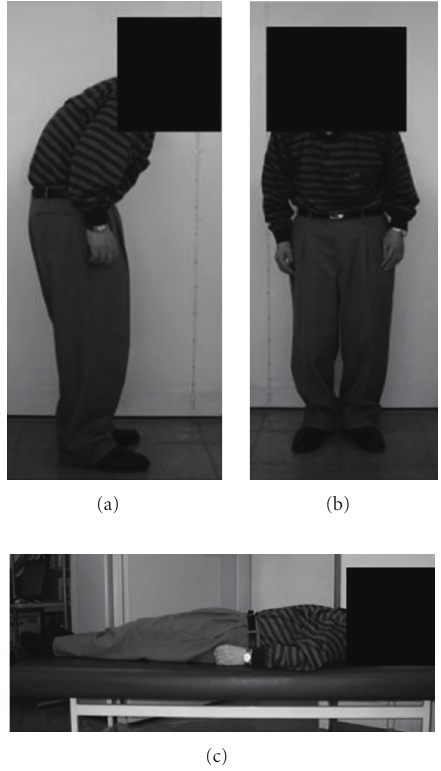
Figure 1: A patient with camptocormia exhibited markedly flexed posture when standing or walking, but was able to lie down in supine